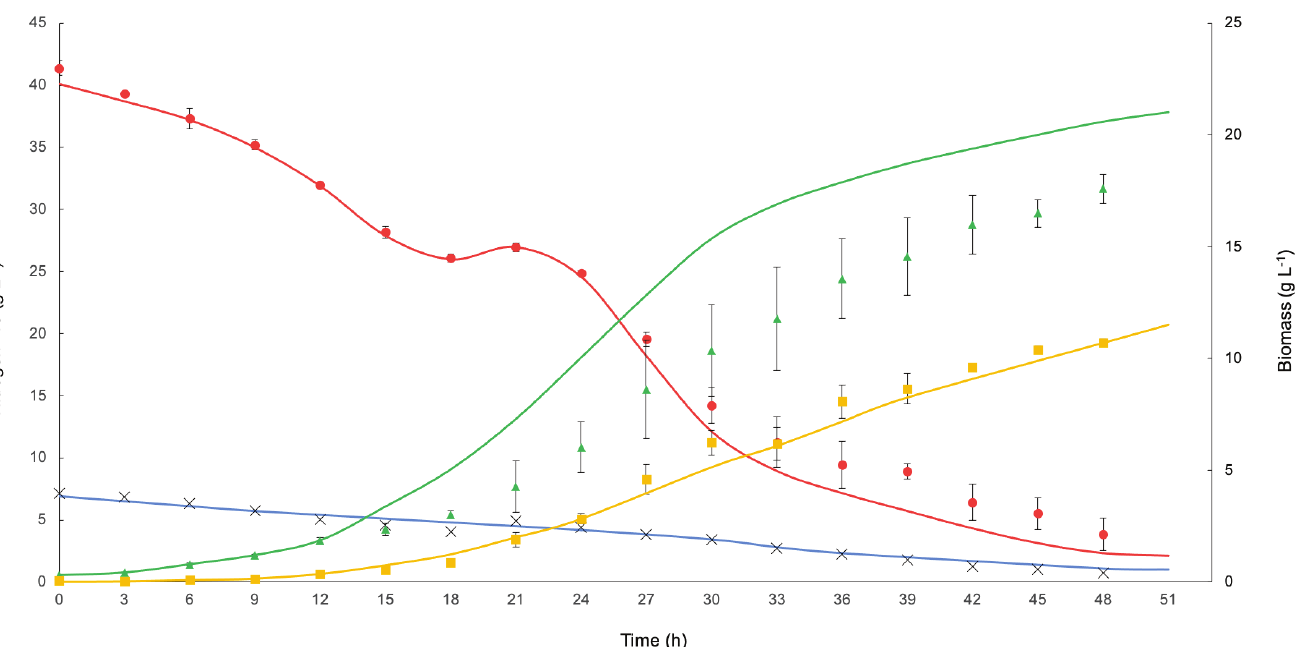
Fig. 7 – Model-based fed-batch cultivation with decreasing feed rate. Comparison between model predictions (smooth lines) and experimental values (data points). 0–16 h Batch, 16–48 h fed-batch; 16–24 h – feeding rate of 75 mL h –1 , 24–32 h – feeding rate of 55 mL h –1 , 32–48 h feeding rate of 35 mL h –1 . End of feeding coincides with end of fermentation (48 h) Data points (● Glycerol, × Nitrogen, ■ PHB, ▲ Biomass) represent the average values of the samples